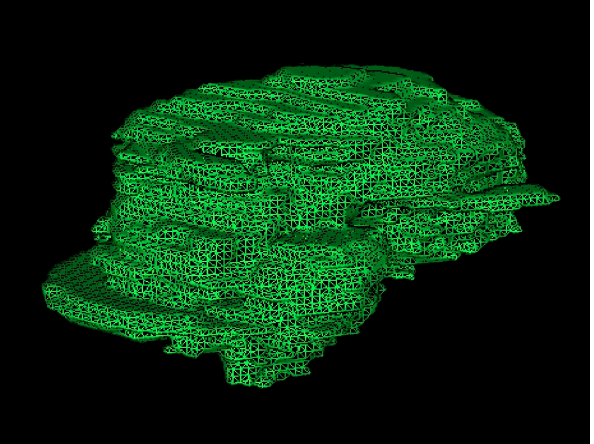
Figure 2. Three-dimensional rendering of total tumor volume in a patient treated for HGG.